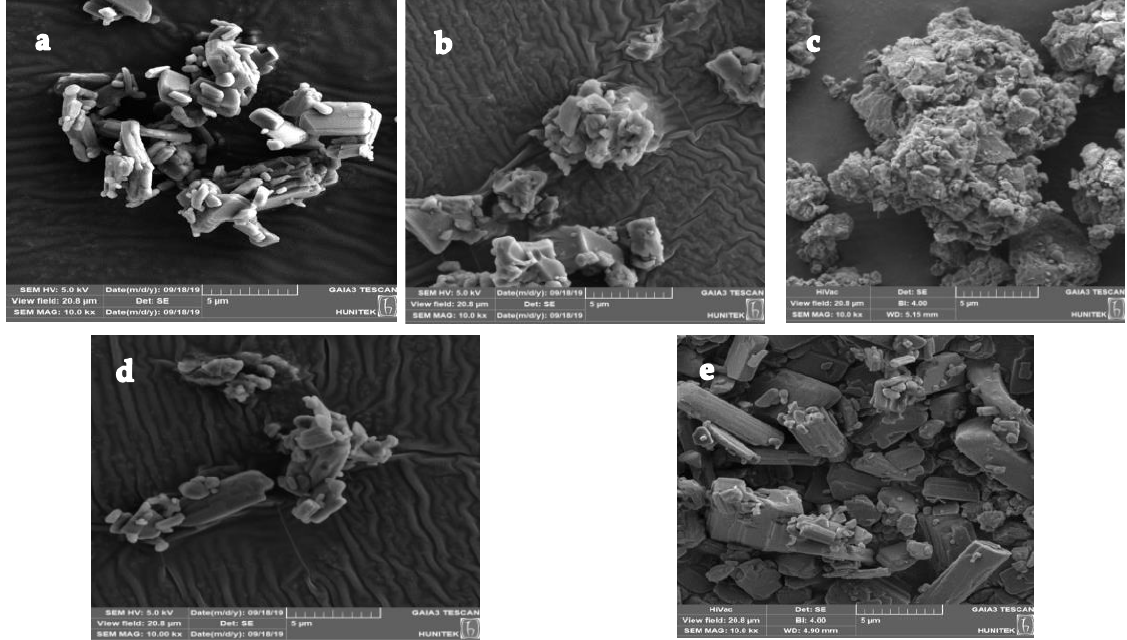
Figure 8. SEM micrographs of: ( a ) celecoxib pure powder, ( b ) co-milled celecoxib with PVP and SLS, ( c )